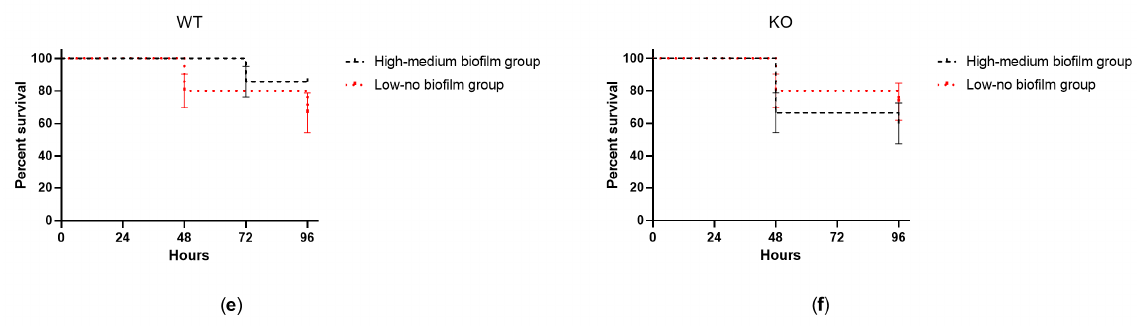
Figure 3. Percent survival of WT and KO mice up to 96 h after intratracheal challenge with clinical isolates showing ( a , b ) high–medium vs. low–no virulence in G. mellonella larvae, ( c , d ) high–medium vs. low–no cytotoxicity in human bronchial epithelial cells, and ( e , f ) high–medium vs. low–no biofilm formation. The mean ± SEM of 16 mice per group ( n = 4 treated with each isolate) is shown. Statistical analysis was performed by log-rank test; ** p < 0.01.